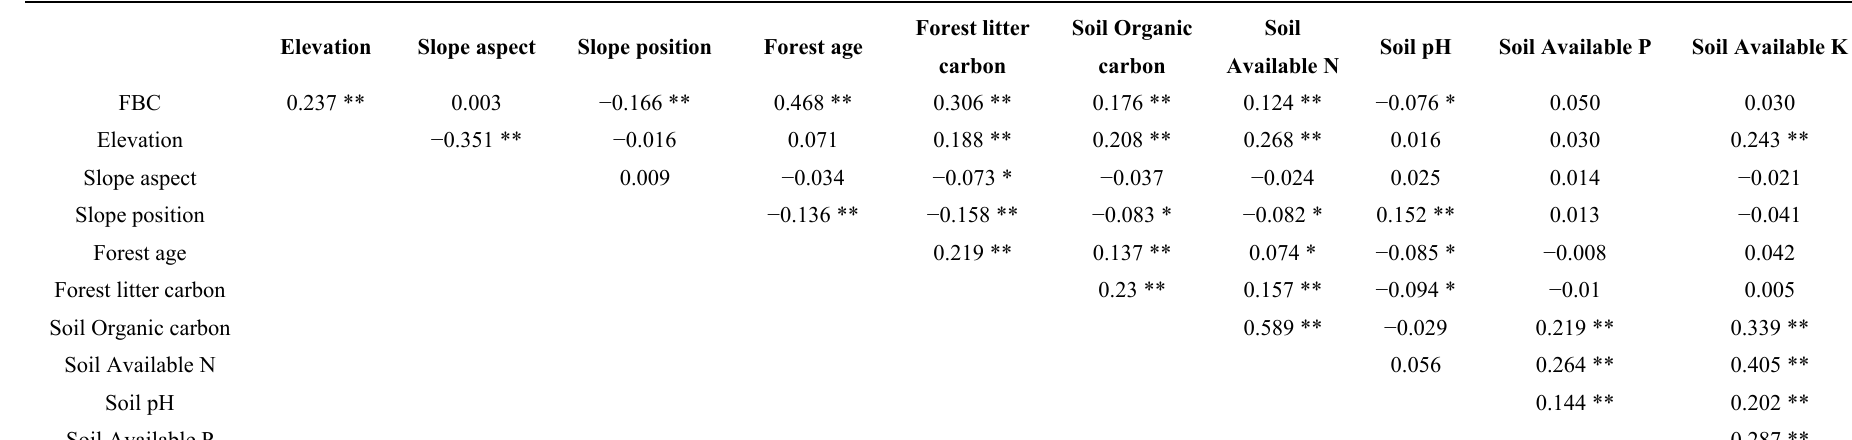
Table 2. Spearman correlation coefficients ( n =